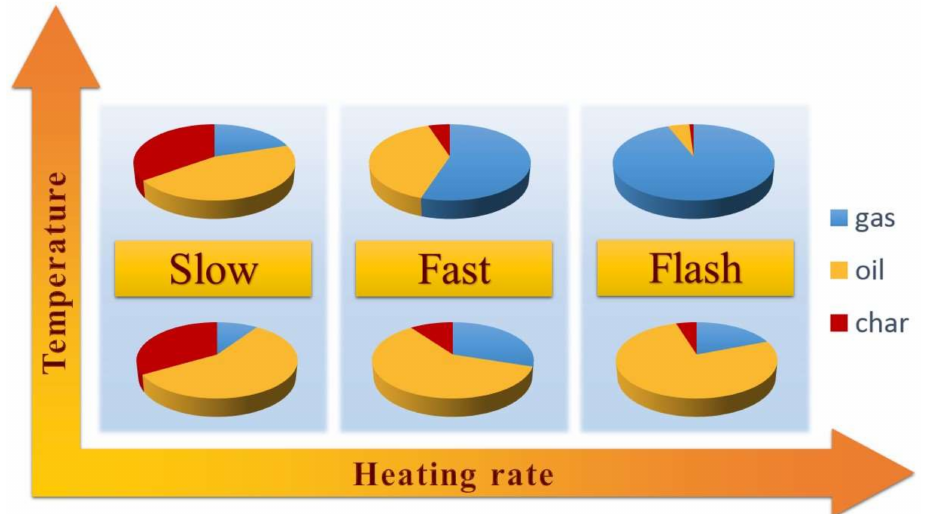
Figure 1. Types of pyrolysis and the impact of process parameters on product